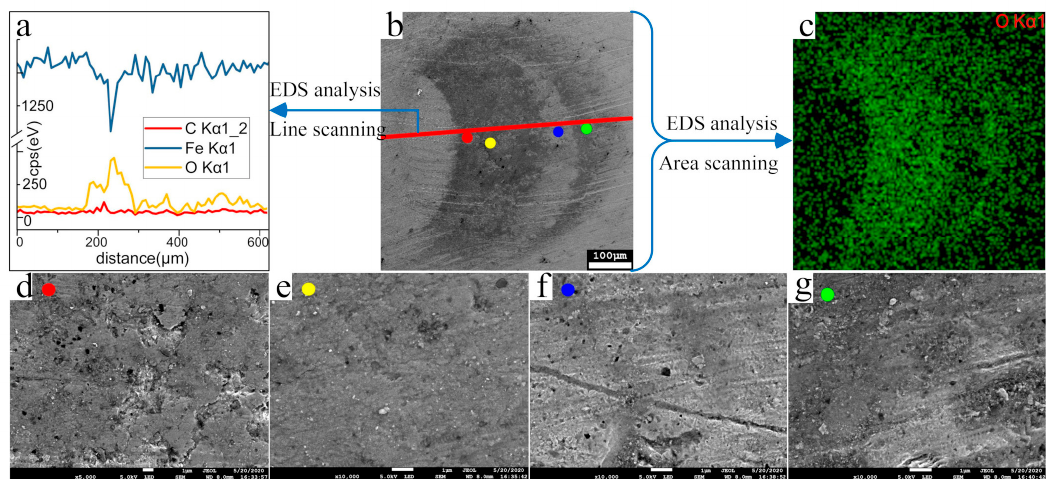
Figure 6. SEM image and EDS detection element distribution of contact point on the ball. ( a ) Element distribution along the red line shown in b; ( b ) SEM image; ( c ) oxygen distribution in the area of b; ( d ) SEM photomicrograph of the position of red spot in b; ( e ) SEM photomicrograph of the position of yellow spot in b; ( f ) SEM photomicrograph of the position of bule spot in b; ( g ) SEM photomicrograph of the position of green spot in b.